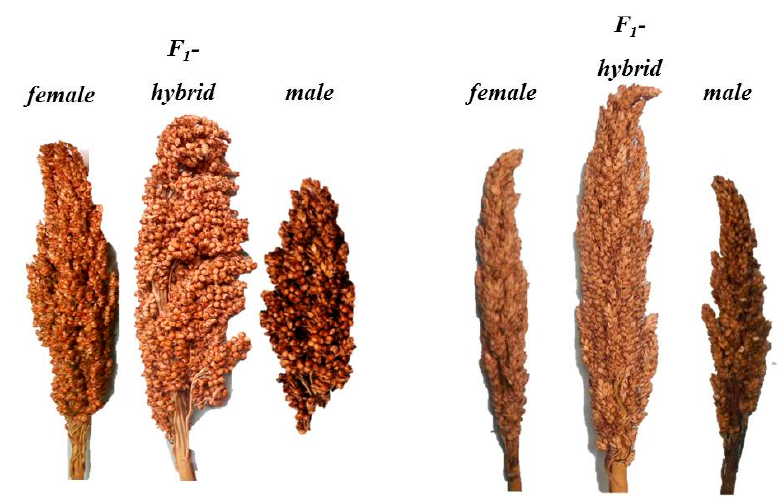
Figure 5. Panicles before threshing from the environment of Texcoco, showing a cold tolerant (left) and a cold sensitive hybrid (right) and their respective parental lines.